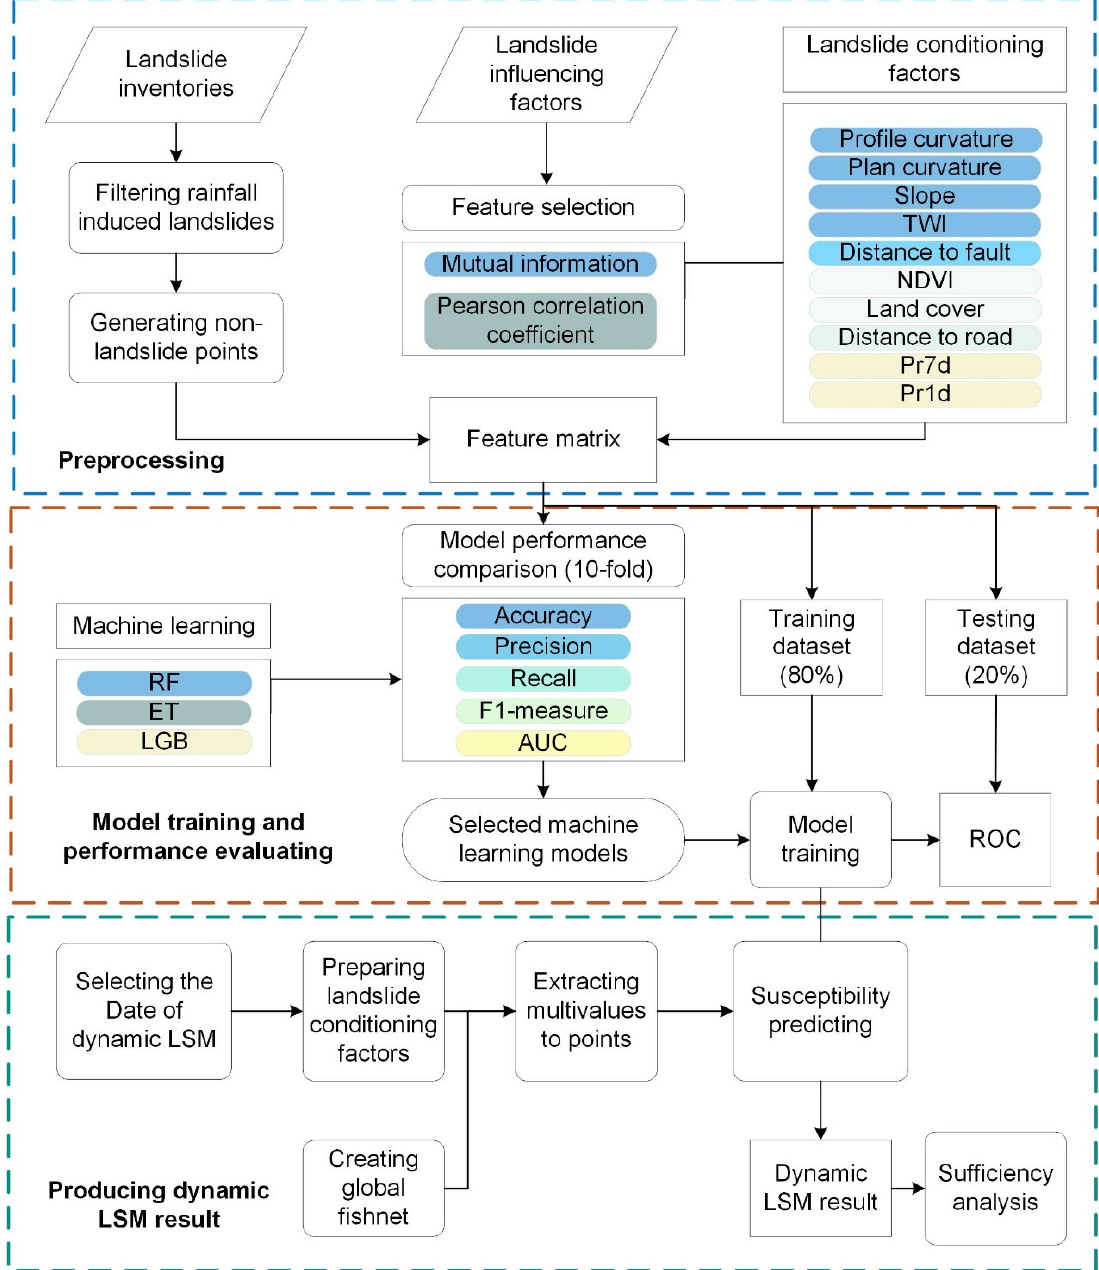
Figure 2. Workflow for constructing the global dynamic LSM model and comparing the performance of different models.